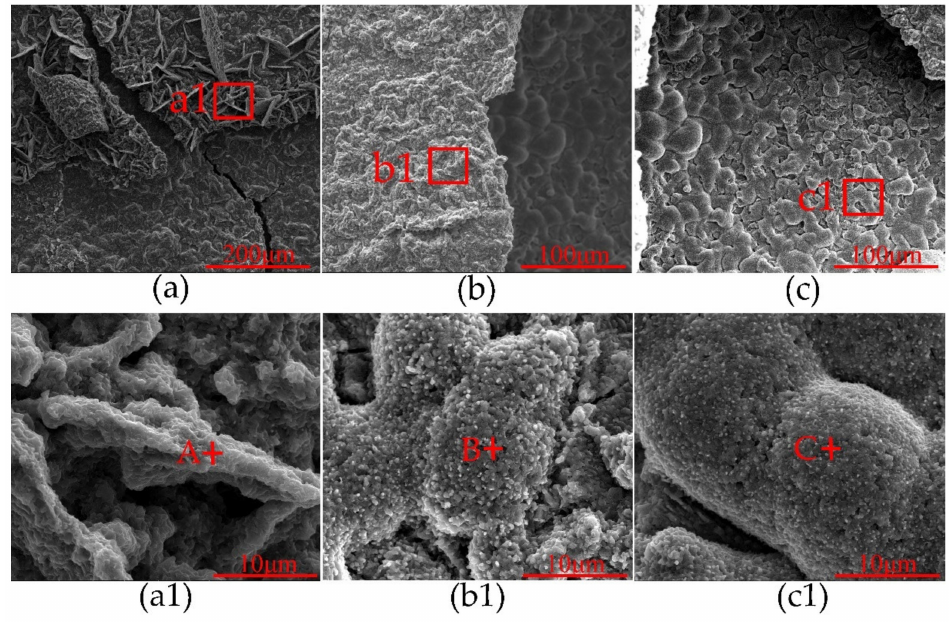
Figure 5. SEM surface micrographs of the corrosion products of: ( a ) outermost layer; ( b ) middle layer; ( c ) the innermost layer of 20G steel corroded in reducing atmosphere for 108 h at 450 ◦ C. Table 2. EDS results for the typical phases of 20G steel corroded in reducing atmosphere for 108 h at 450 ◦ C in Figure 5.